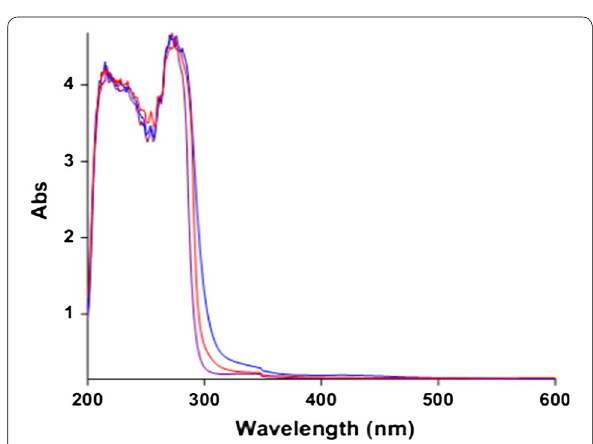
Fig. 2 The UV spectrum of 10 − 2 M of ( 1 ), ( N – H ) compound and 5 10 − 3 M of ( 2 ) as a catalyst in ×